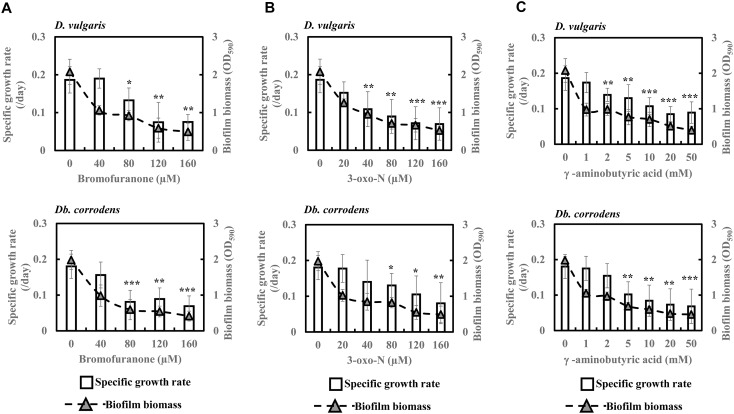
Quorum sensing inhibitors (QSIs) and the effect on specific growth rate and biofilm formation of D. vulgaris and Db. corrodens in saline media. (A) Effect of bromofuranone on specific growth rate and biofilm formation of D. vulgaris (upper panel) and Db. corrodens (lower panel). (B) Effect of 3-oxo-N on specific growth rate and biofilm formation of D. vulgaris (upper panel) and Db. corrodens (lower panel). (C) Effect of γ-aminobutyric acid (GABA) on specific growth rate and biofilm formation of D. vulgaris (upper panel) and Db. corrodens (lower panel). Bar chart illustrates specific growth rate plot and dotted line scatter plot illustrates biofilm biomass plot. Results are presented as mean ± standard deviation (n = 3). Significant difference in specific growth rate: ∗p < 0.05; ∗∗p < 0.01; ∗∗∗p < 0.001.